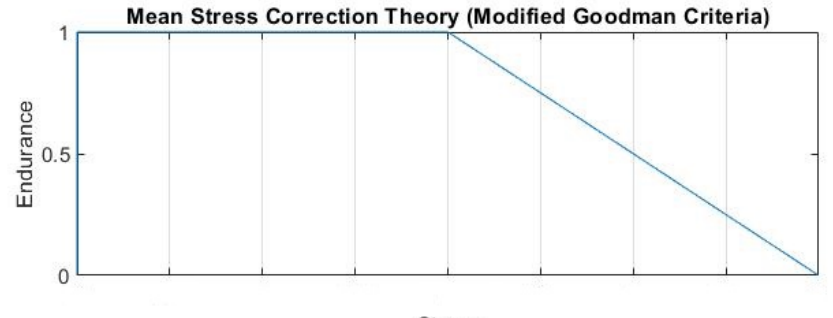
Figure 4. Mean stress correction theory.